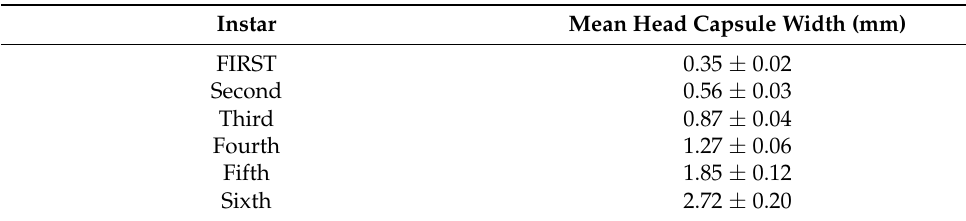
Table 1. The head capsule widths of FAW larval instars observed under controlled laboratory conditions of 25 ◦ C and 70% relative humidity (Montezano et al. 2019